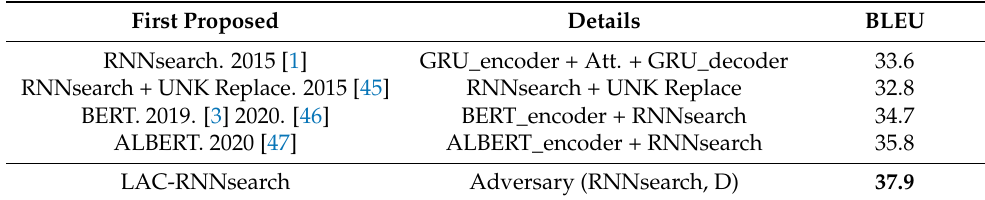
Table 3. Comparison of baseline models.